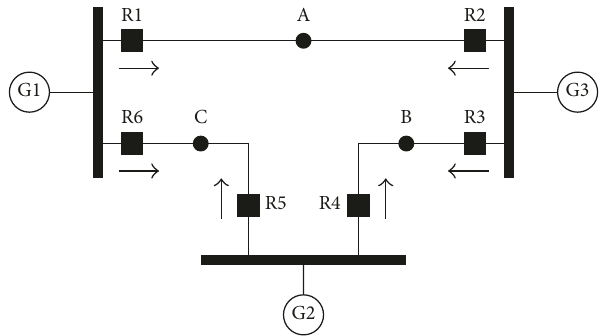
Figure 1: IEEE 3-bus DOCRs coordination problem model. Table 1: P/B pairs and related parameters for the 3-bus system [16]. Primary